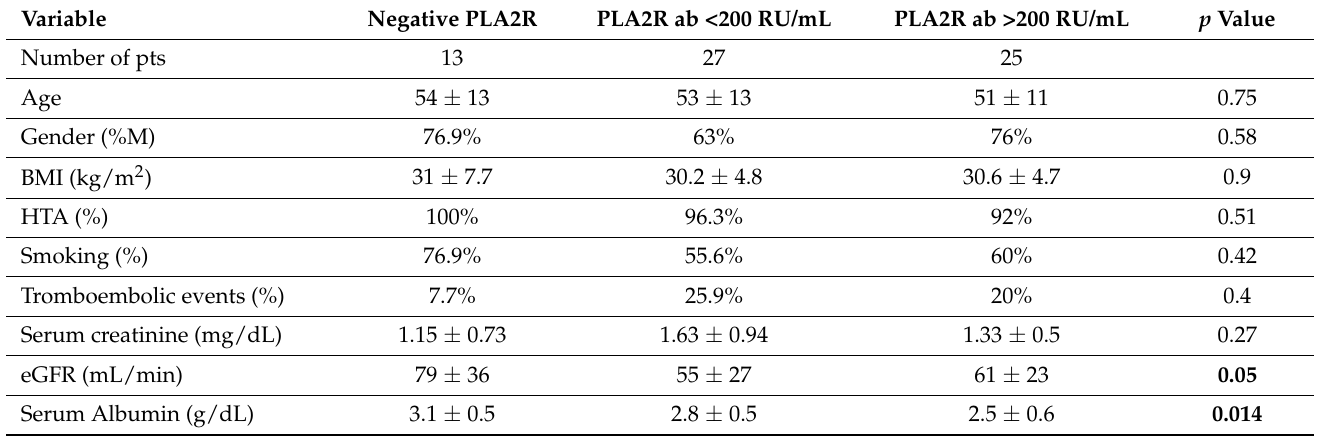
Table 1. Univariate analysis according to baseline anti-PLA2R antibody